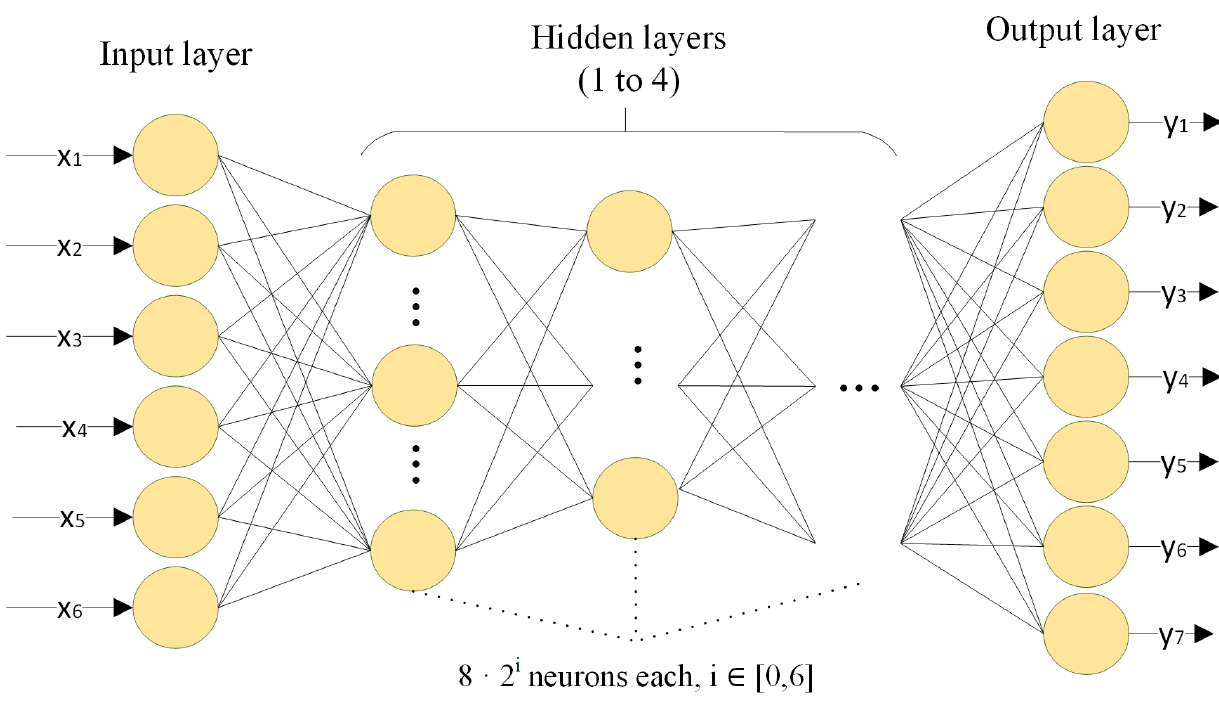
Figure 4. Diagram of the different ANN architectures analyzed in this